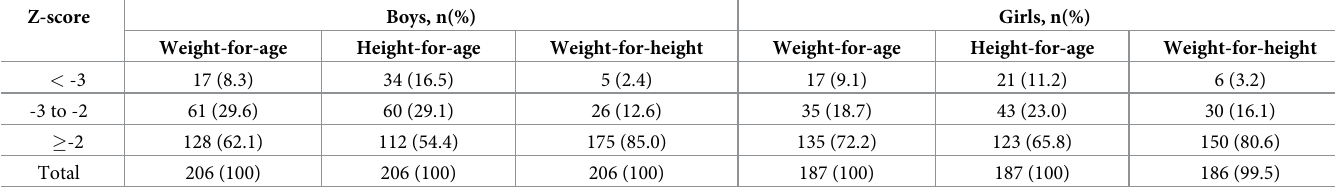
Table 2. Distribution of preschool-age children according to z-scores of anthropometric measurements. Z-score Boys, n(%) Girls, n(%) Weight-for-age Height-for-age Weight-for-height Weight-for-age Height-for-age